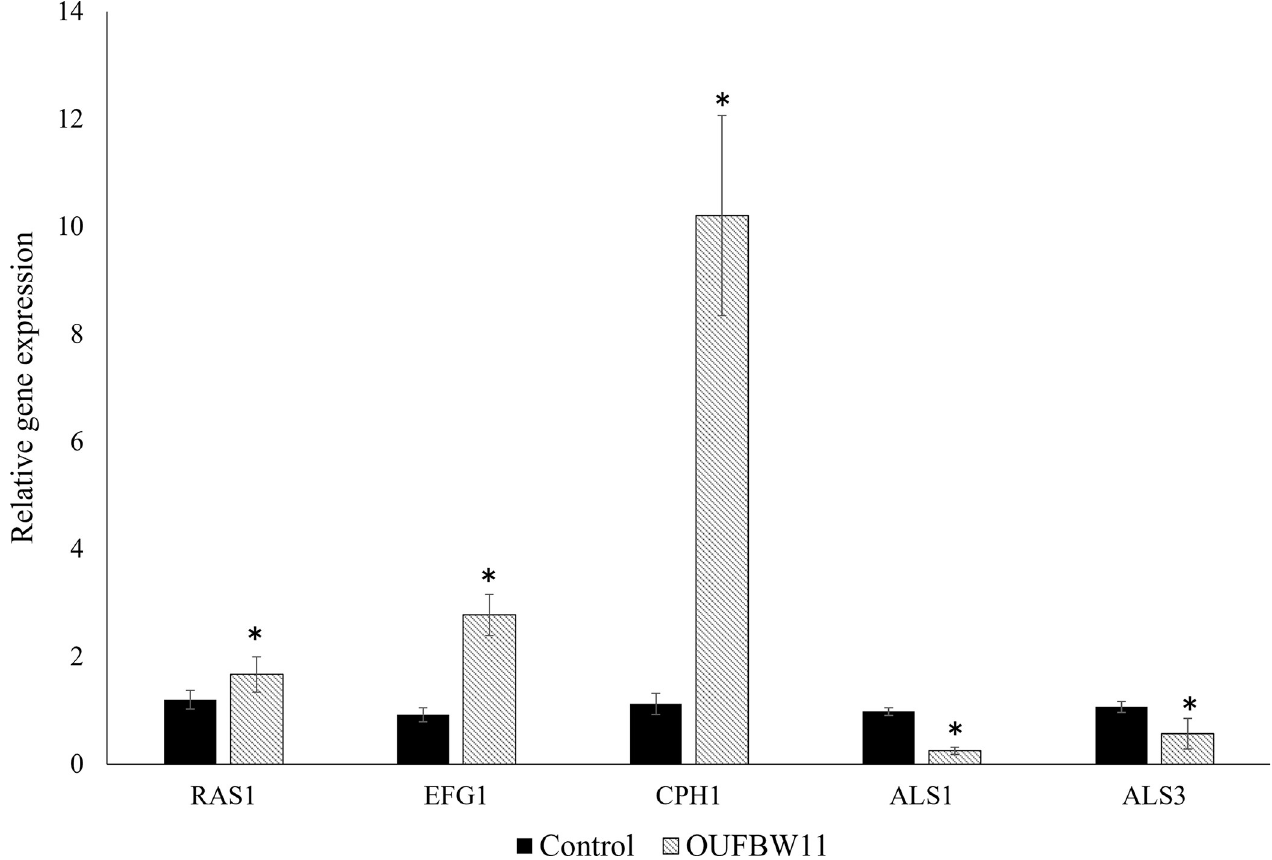
Fig 6. qRT-PCR analysis of the expressions of biofilm formation and hyphal growth. The experiments were repeated three times. ( � : p < 0.05).